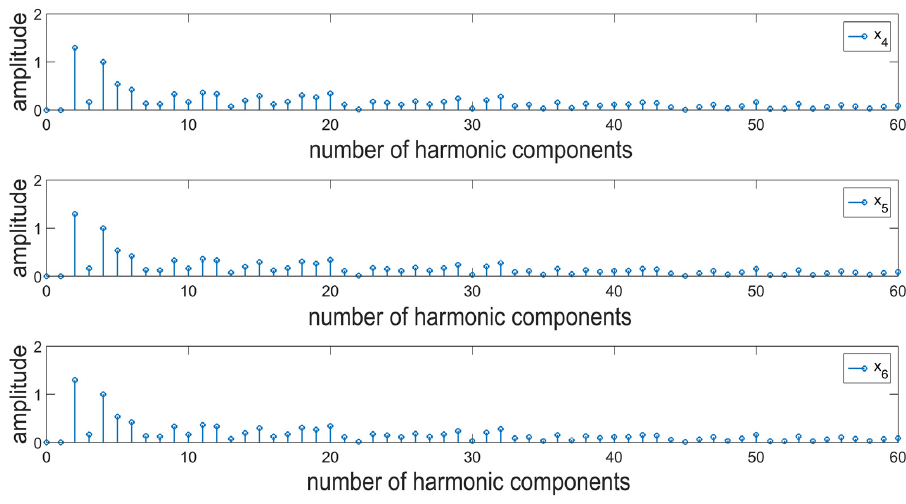
Figure 8. Amplitude spectral density of the roundness profiles of rollers in rolling bearings. Surface profiles being a composition of periodic and aperiodic irregularities in the generated spectrum are defined by a significantly higher number of harmonic components. The assessment of irregularities in the individual bands will allow for narrowing down the scope of the analysis, which at the initial stages of decomposition results in an analysis of fast-changing information corresponding to the introduced disruptions. Figure 8 presents the results of the analysis of details generated at the fi rst level of decomposition of signals, performed by means of the db2 wavelet. In this case, di ff erences in the amplitude values were recorded for a single harmonic corresponding to the value of the modeled function. In the case of noise, a similar distribution of amplitude values can be observed; however, the values are proportionally higher (Figure 9). At the subsequent stages of the analysis; the resulting spectra contain no clear information about the signal. It was, therefore, deemed reasonable to use a di ff erent mother wavelet, the support width of which is even shorter, i.e., db1. The dbN family of wavelets (Daubechies), where N refers to the number of vanishing moments and wavelet order, is characterized by 2 N-1 compact support [54]. For the db1 wavelet, information in the detail signals was acquired in a clearer manner (Figure 10). Therefore, it can be concluded that for non-stationary signals, the use of wavelets with possibly short support width results in be tt er diagnostics of the signal. In the upper part of Figure 10, there are noticeable di ff erences for the 50th harmonic between the surface pro fi le resulting from the measurements and the signal resulting from the addition of an additional function. There is also a noticeable level of decomposition, for which the additional component has been removed. In the case of noise, it is also possible to record the level of decomposition for which it has been fi ltered out. Since the wavelet analysis is a lossless transformation [55], the signal can be reconstructed, and the possible causes of the resulting defect can be analyzed to a given level.